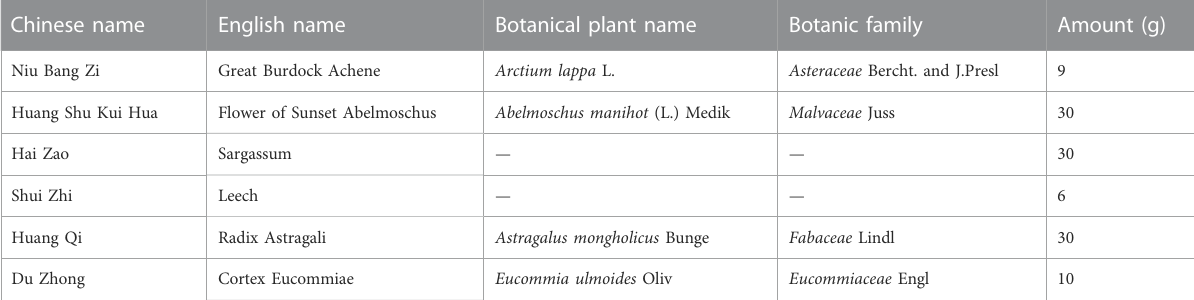
TABLE 1 Composition and doses of Qing-Re-Xiao-Zheng-Yi-Qi Formula